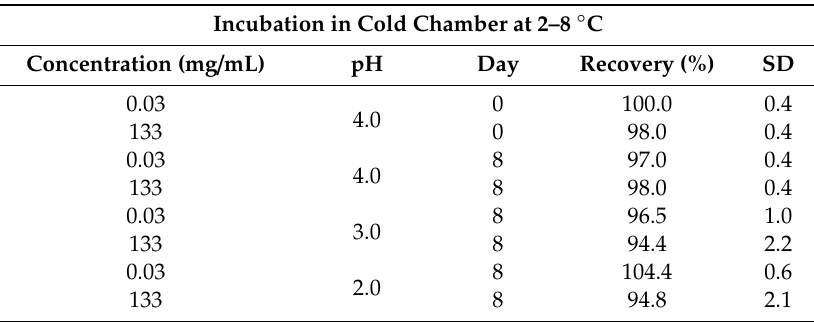
Table 3. ABN401 remaining in oral gavage formulation after 8 days of